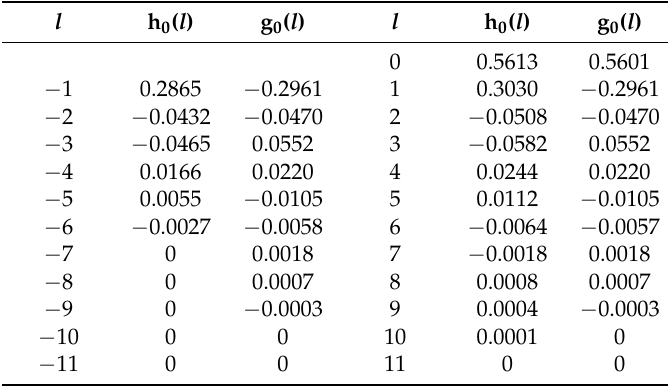
Table 1. Coefficients of quasi-orthogonal bi-orthogonal filters.